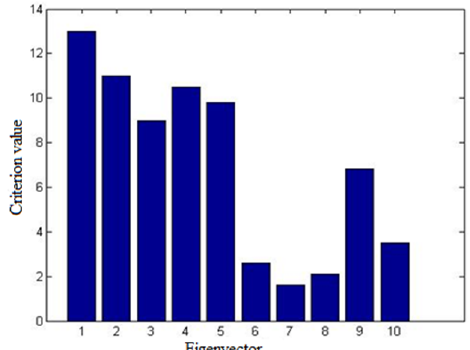
Figure 7. Criterion values for ten geometric characteristics, which are respectively the expectation of the slope of fitted straight lines, the expectation of closed curve areas, the variance of closed curve areas, the variance of the slope of the fitted straight lines, the number of the closed curves that exceed the threshold area, the expectation of closed curve lengths, the variance of closed curve lengths, the number of fitted straight lines, the maximum difference of the fitted line slopes and the number of closed curves of the impedance diagram.